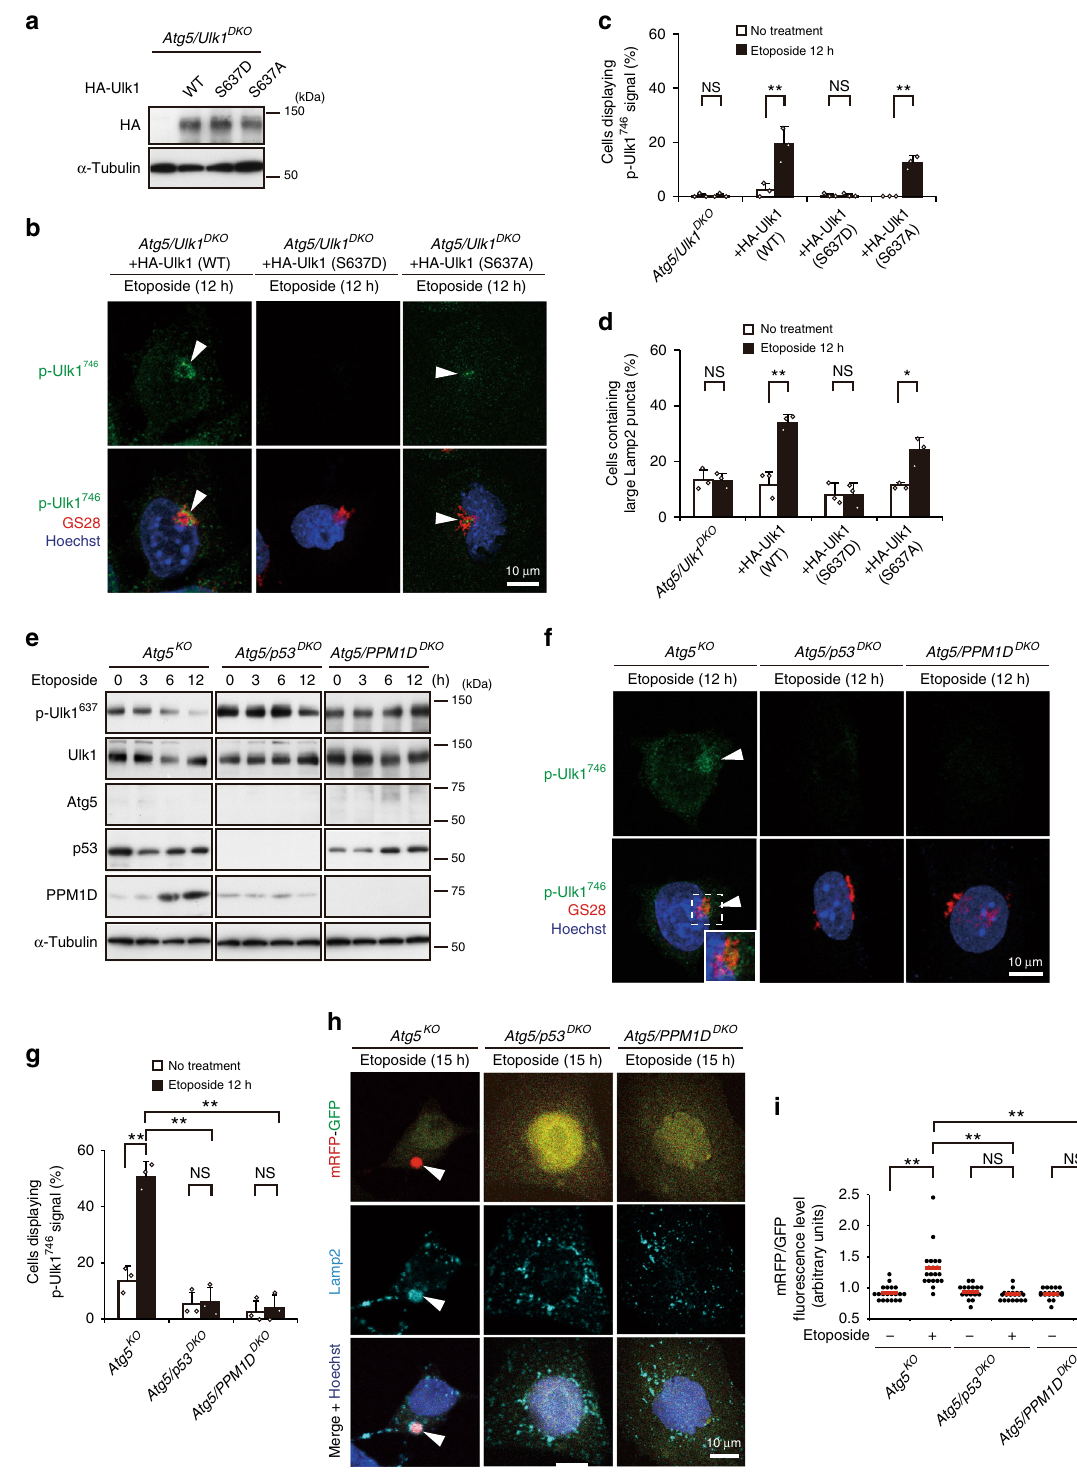
are thought to be autolysosomes. In contrast, in Atg5/ RIPK3 DKO MEFs, etoposide generated unusual cytoplasmic integrin alpha5 puncta (Fig. 10a, image 13), which should be the undelivered and undegraded integrin alpha5. E64d/ pepstatin did not show any effects on this integrin alpha5 localization (Fig. 10a, image 16) and expression (Fig. 10b). Consistently, merged puncta of integrin alpha5 and Lamp1